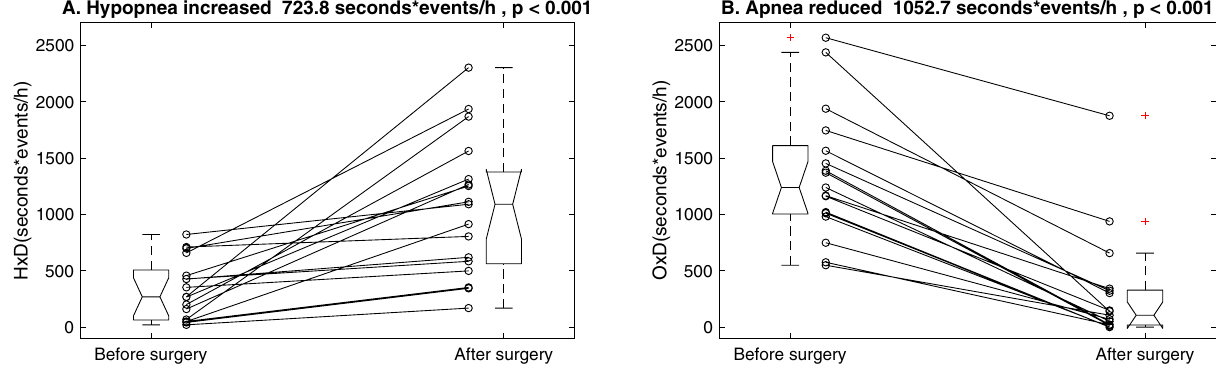
Figure 1. Individual product of ( A ) hypopnea index and mean hypopnea duration and ( B ) obstructive-apnea index and mean obstructive-apnea duration before and after the surgery. The surgery reduced the product on obstructive apnea but increased that on hypopnea.